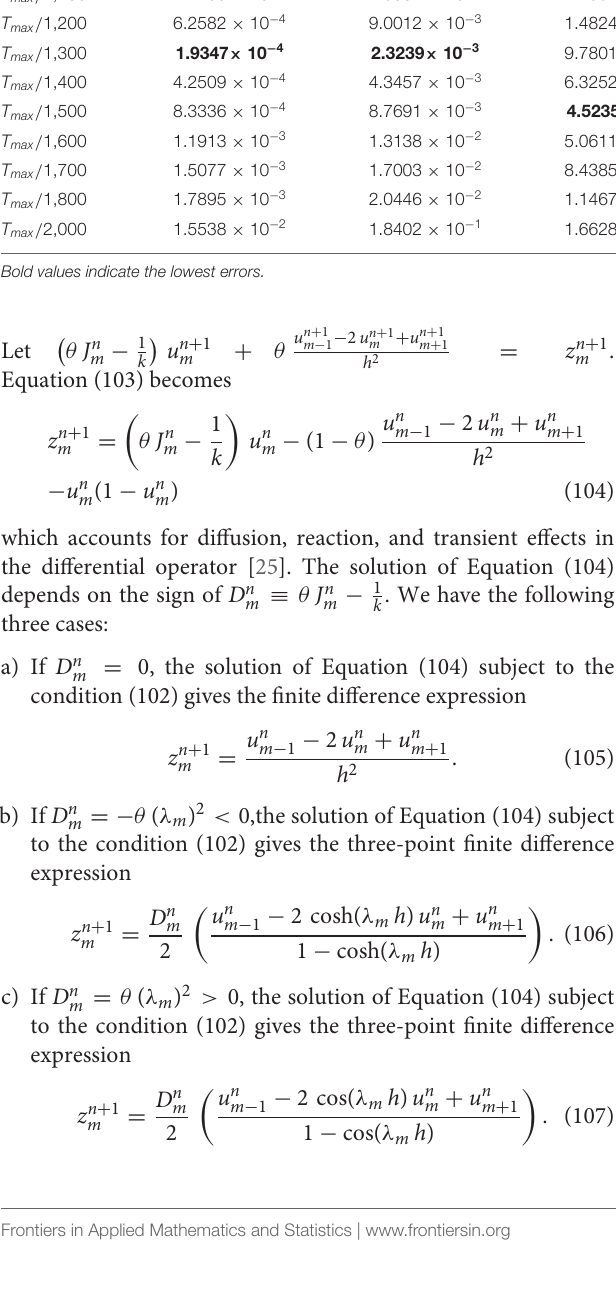
TABLE 3 | L 1 and L Values of